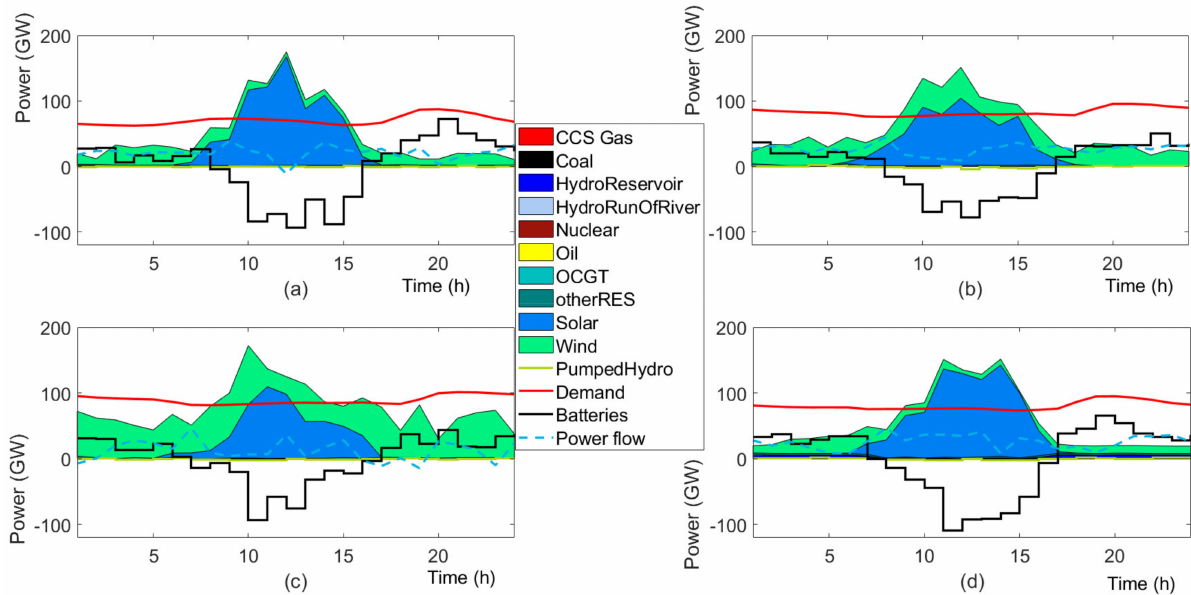
Figure 15. Generation mix in region ER according to scenario node 8, with the availability of storage, in four typical days. Figure ( a ) reports a typical day within the period January–March, ( b ) a typical day within April–June, ( c ) a typical day within July–September, and ( d ) a typical day within